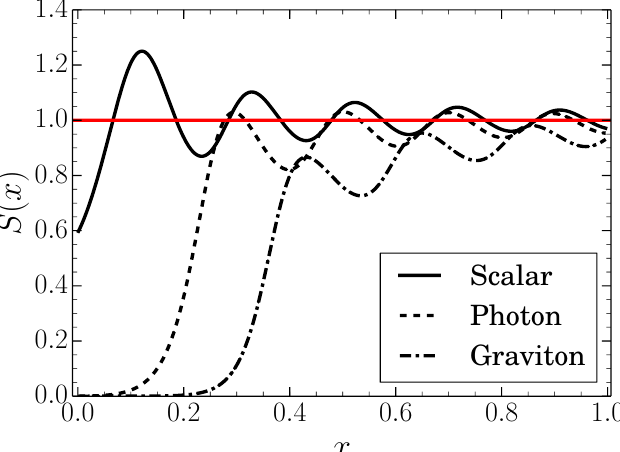
Figure 5. Regge–Wheeler for Schwarzschild: Dimensionless cross-sections . The dimensionless cross-section S ( x ) , see Equation (25), plotted for scalars, photons, and gravitons for a Schwarzschild black